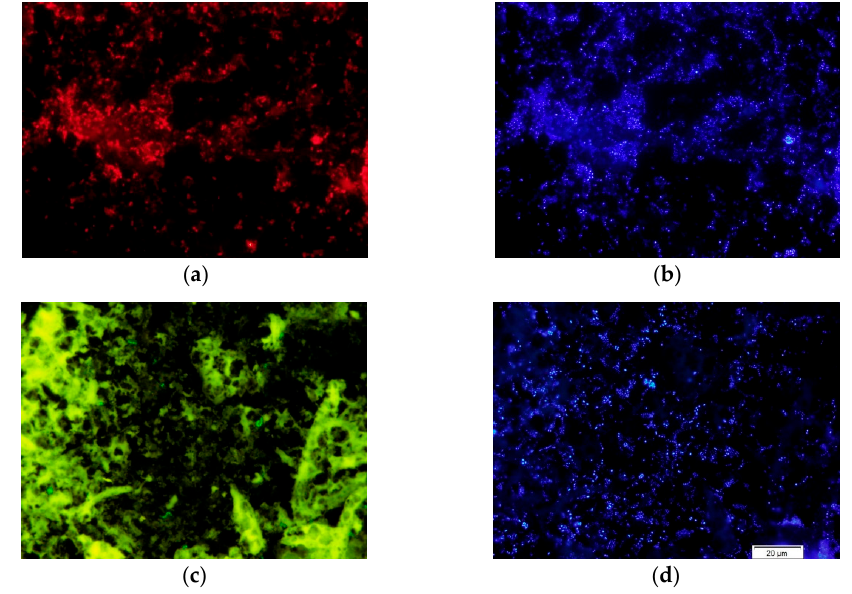
Figure 2. Fluorescence in situ hybridization (FISH) of the uropygial secretion. Fluorescence microphotographs of a hoopoe breeding female secretion hybridized with the universal probe Eub338 labeled with cyanine 3 (Cy3, red) ( a ) and the genus Enterococcus -specific RNA probe Enc221 labeled with fluorescein-5-isothiocyanate (FITC, green-yellow) ( c ). Images ( b , d ) are from the same microscopic fields as ( a , c ), respectively, taken through the 4 ′ ,6-diamidino-2-phenylindole (DAPI, blue) filter to observe the staining of bacterial DNA with Hoechst.